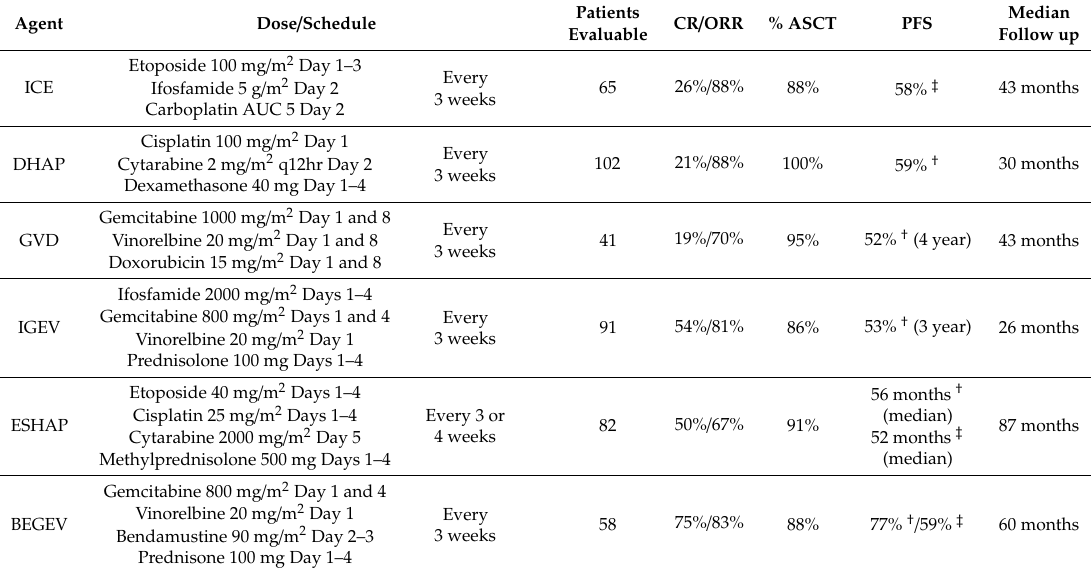
Table 1. Salvage chemotherapy options for relapsed or refractory (r / r) classical Hodgkin lymphoma. Agent Dose / Schedule